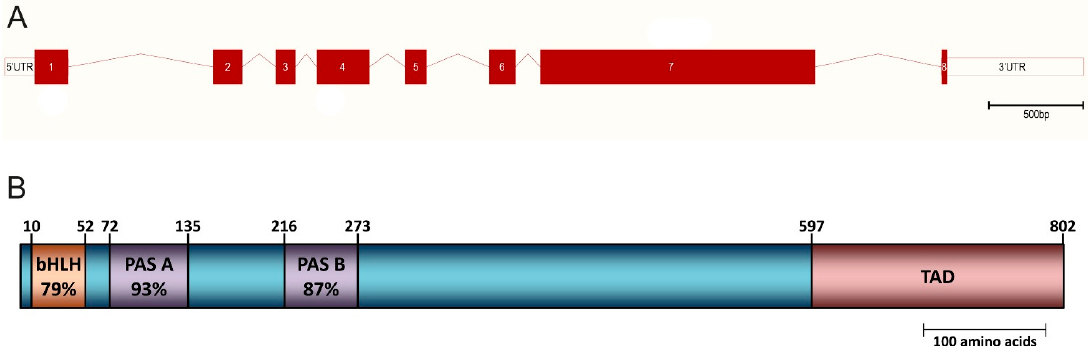
Figure 1. ( A ) The genomic structure of the mouse Npas4 gene. The Npas4 -coding region is organized into eight exons and spans a genomic region of approximately 5.6 kb. Filled boxes represent exons, empty boxes represent UTRs and lines between filled boxes represent introns; ( B ) The domain structure of the mouse Npas4 protein showing the location of the basic Helix-Loop-Helix (bHLH), Per-Arnt-Sim (PAS) domains as well as the transactivation domain (TAD). Conservation of each domain to the domain consensus sequence is also indicated (percentage amino acid identity).